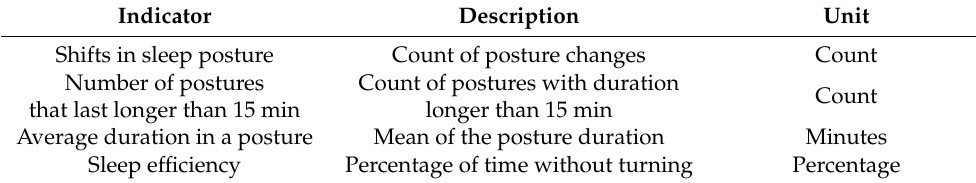
Table 2. Indicators of sleep quality.